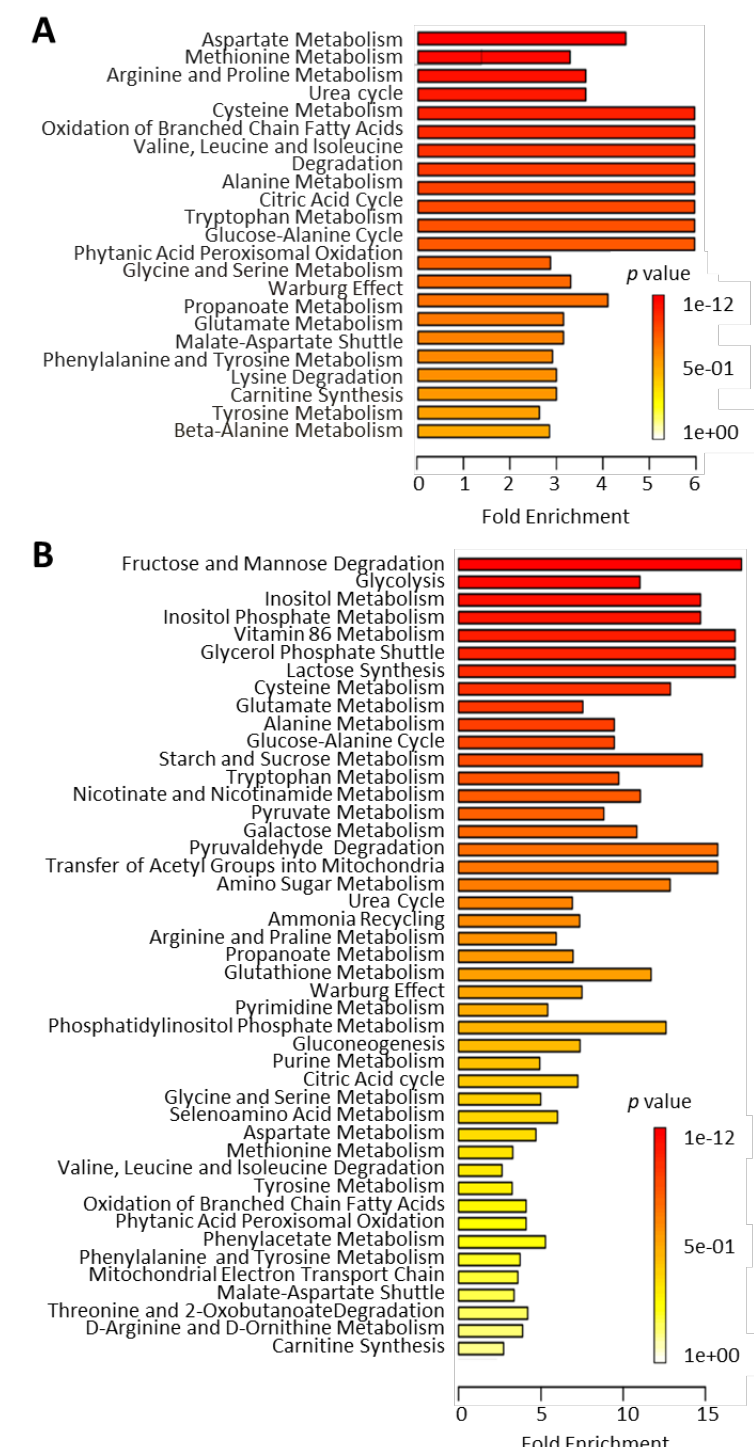
Figure 4. Metabolic pathways associated with metabolite sets that were ( A ) equally distributed or ( B ) significantly enriched in aqueous humor versus plasma samples collected from normoglycemic C57BL/6 and NOD mice ( n = 10 each). Figures obtained using the quantitative enrichment analysis (QEA) approach of the metabolite set enrichment analysis (MSEA) tool of MetaboAnalyst. Pathways are shown in order of decreasing significance from top to bottom (increasing nominal p values, colored from red to yellow) with bars indicating their estimated fold enrichment (see [32] for